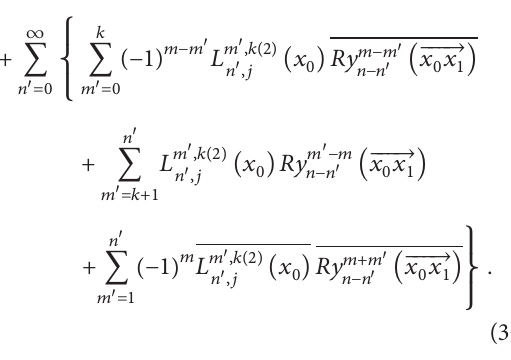
Figure 11: Zoom 2 of Figure